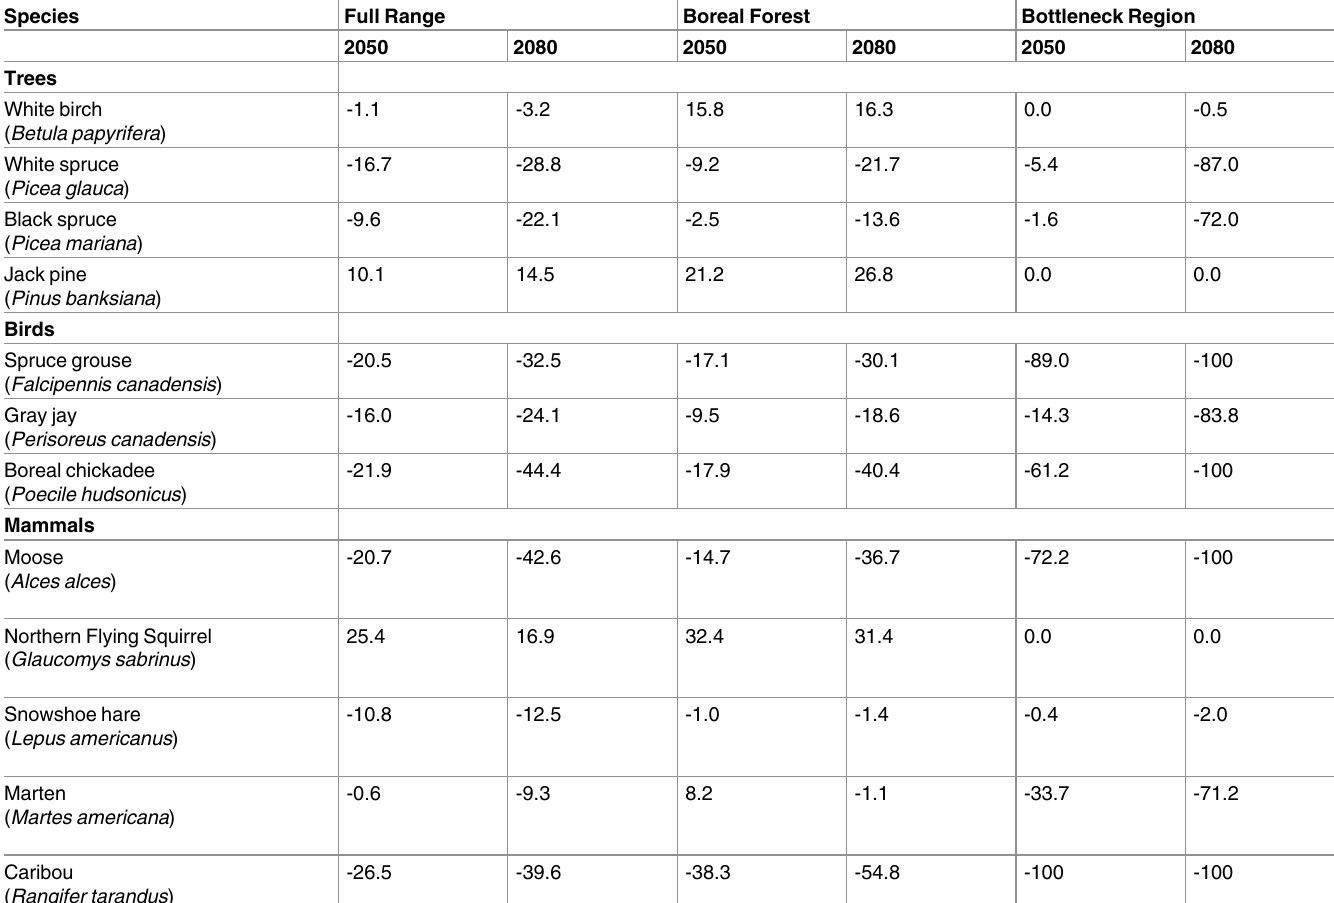
Table 1. Percent change in climate suitability of boreal forest species between current and future climate projections (i.e. 2050and 2080). Changes were calculatedfor the full current range of each species, the current extent of the borealforest, and the Ontario-Que´bec